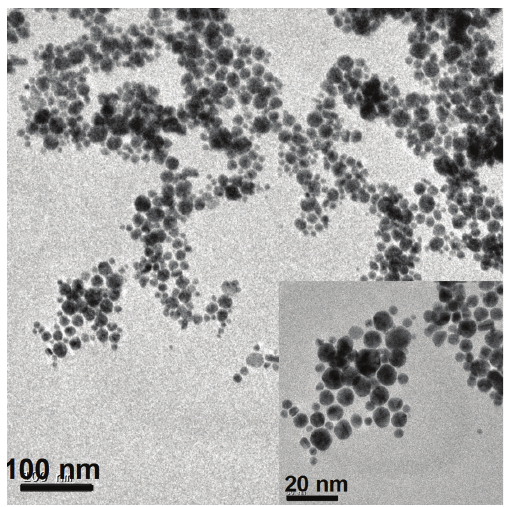
Figure 2: Transmission electron microscopy of AuNPs synthesized by TPB act as reductant Inset . Higher magnification of AuNPs.